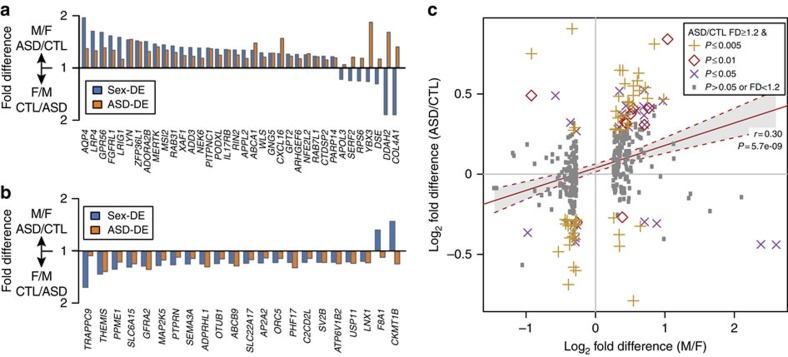
Sex-differential expression parallels gene expression patterns in ASD brain.Bar plots show FDs by sex and ASD status of sex-DE genes (FD≥1.2 and P<0.05) that also belong to ASD-associated co-expression modules24. (a) Module asdM16V, which is significantly upregulated in ASD and enriched for genes involved in the inflammatory response and immune system functions, and (b) module asdM12V, which is significantly downregulated in ASD and enriched for genes with neuronal and synaptic functions. (c) FDs of sex-DE genes (FD≥1.2, P<0.05, 374 genes) by sex and status. Best-fit line and its 95% confidence interval are shown. CTL, control from ASD expression study; F, female; M, male.